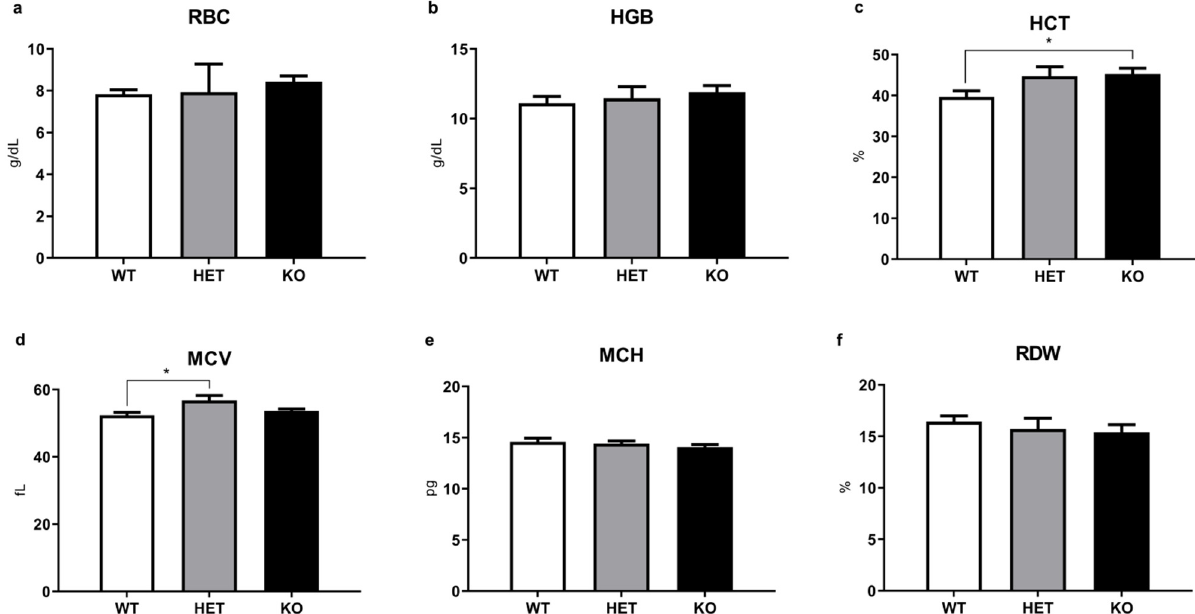
Figure 4. Other routine and additional CBC parameters of WT, HET, and TAAR5-KO (KO) mice. No changes were detected in red blood cells (RBC) ( a ), hemoglobin (HGB) ( b ), mean corpuscular hemoglobin (MCH) ( e ), red blood cell distribution width (RDW) ( f ). Minor but significant alterations were found in hematocrit (HCT) ( c ) and mean corpuscular volume (MCV) ( d ) levels. Data are mean ± SEM. * p < 0.05, vs. WT, one-way ANOVA, post-hoc Tukey test.